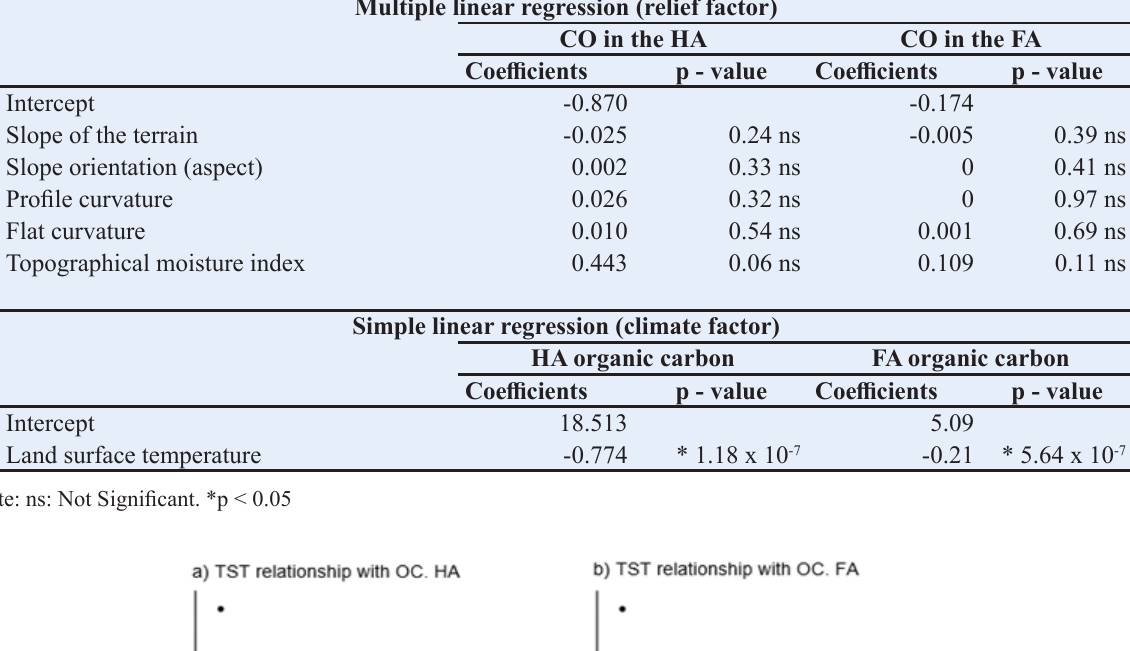
Table 4 : Coefficients between morphoclimatic variables and organic carbon content in HA and FA (p is significance level).